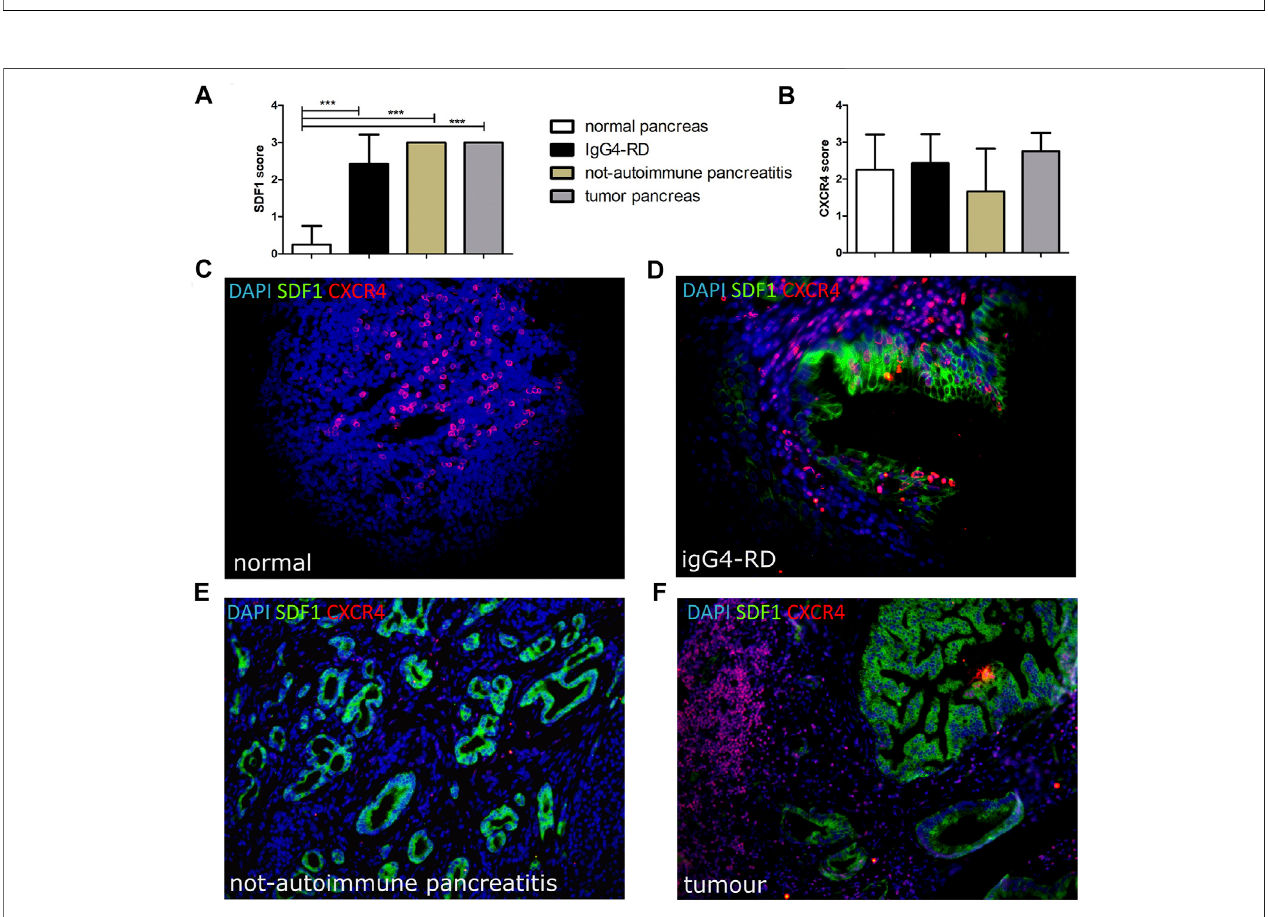
FIGURE 2 | SDF-1/CXCL12 (A) and CXCR4 (B) score in pancreatic tissues from normal, IgG4-RD, not-autoimmune pancreatitis, and tumor pancreas. A representative image of a double staining SDF-1/CXCR4 in normal pancreas (C) , IgG4-RD pancreas (D) , not-autoimmune pancreatitis (E) , and tumor pancreas (F) is shown. ppp (cid:1) p <